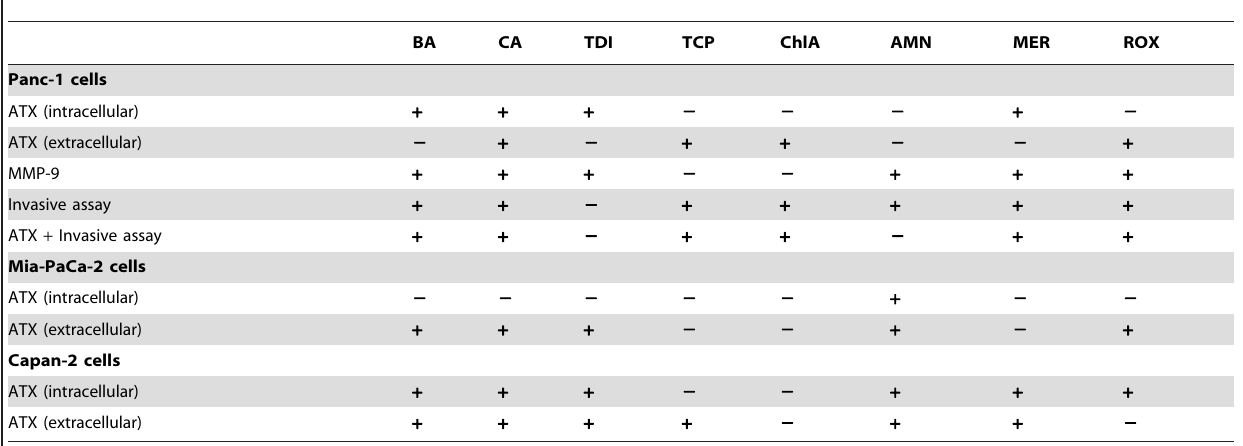
Table 4. Summary of results obtained in Panc-1, Mia-PaCa-2 and Capan-2 cells.